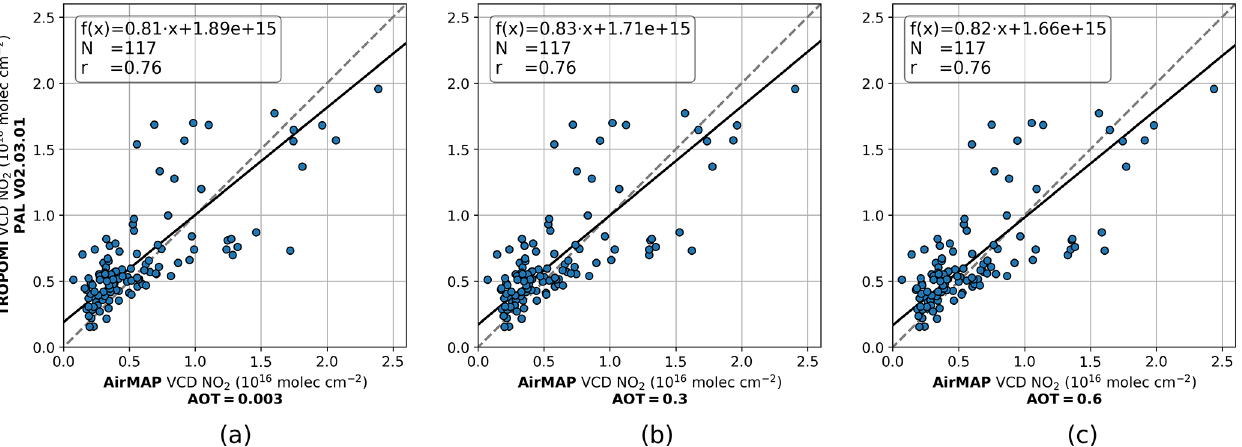
Figure A3. Scatter plots of TROPOMI PAL V02.03.01 tropospheric NO 2 VCDs vs. co-located AirMAP tropospheric NO 2 VCDs with an (a) AOT of 0.003, (b) AOT of 0.3, and (c) AOT of 0.6. AirMAP measurements are considered as co-located and gridded to the TROPOMI pixel if they are taken ± 30min around the S5P overpass and are covering at least 75% of the TROPOMI